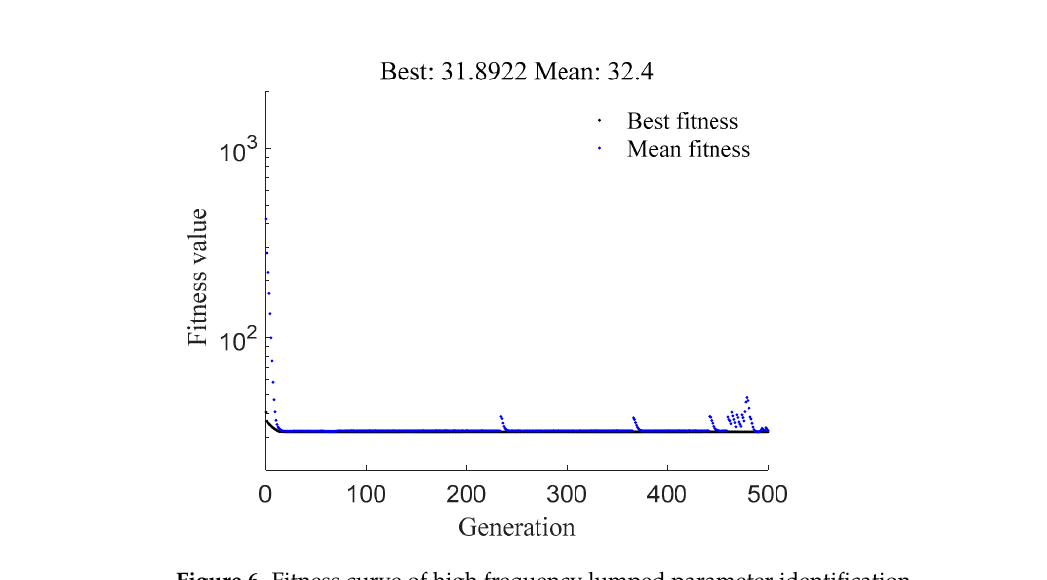
Figure 6. Fitness curve of high frequency lumped parameter identification.